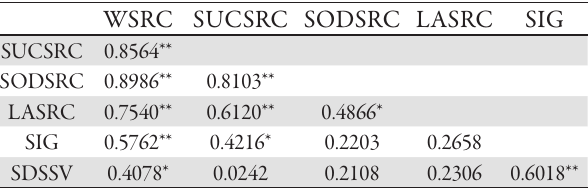
Tab. 5. Correlation among SIG, SDS, SRCs of